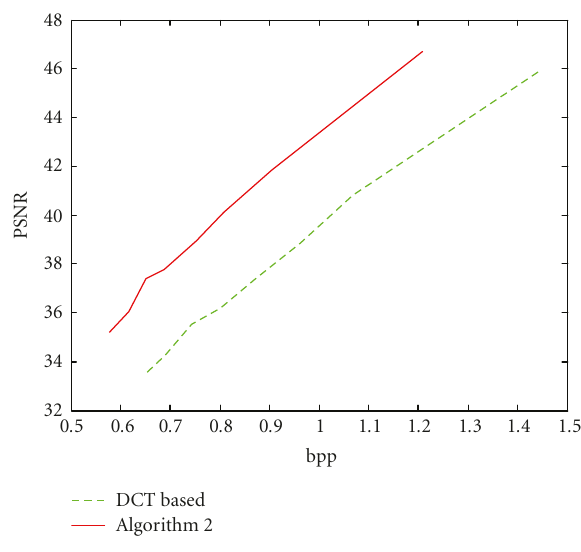
(b) Compound image: Algorithm 2 versus DCT-based compression Figure 8: PSNR versus bitrate plots for images: (a) “Kidney” ( c = 0 . 9, α = 1); (b) “Compound” ( c = 0 . 5, α = 1).